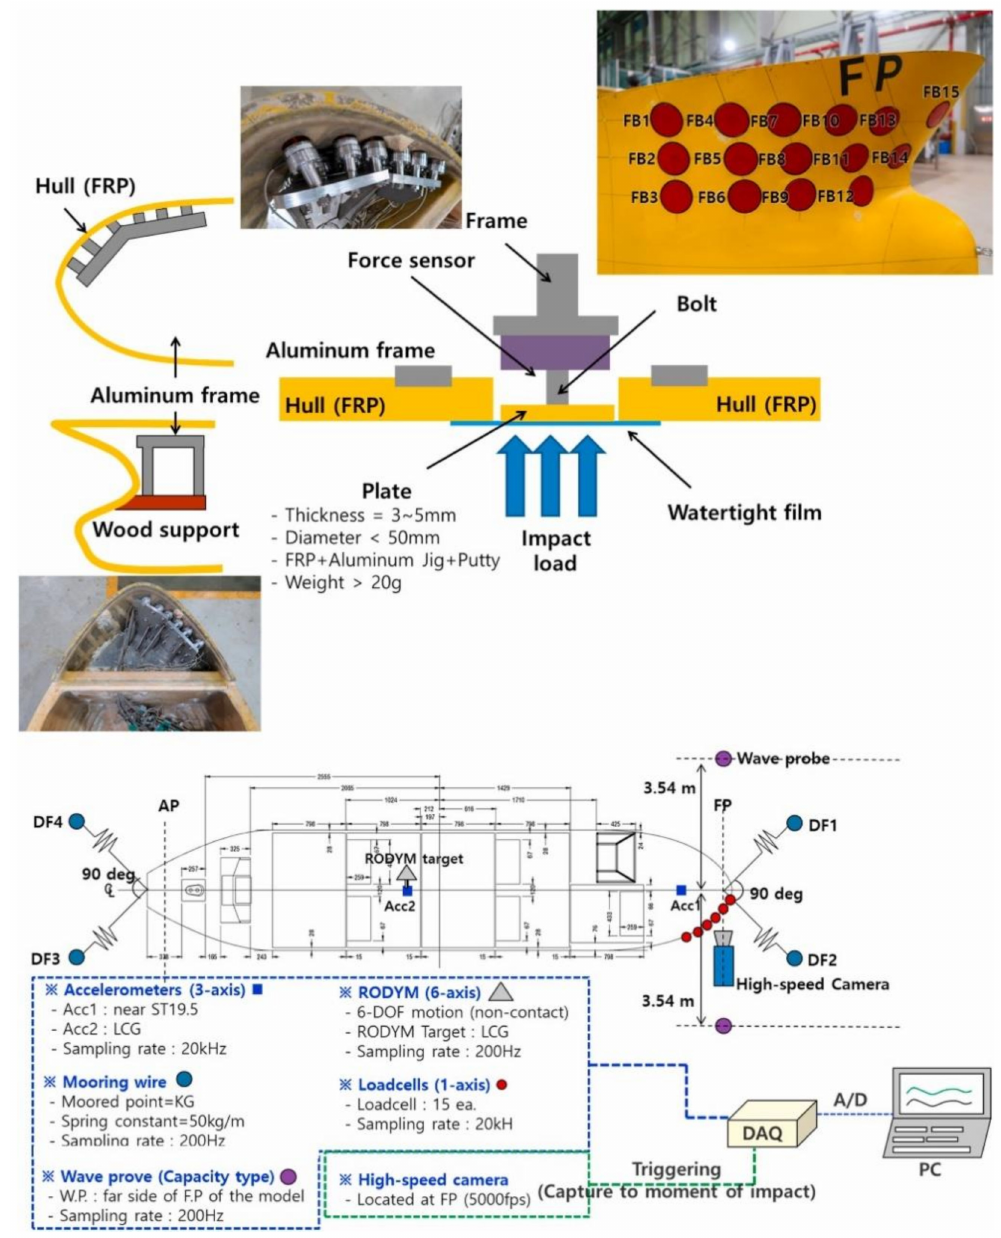
Figure 11. TENG tilt sensor experimental apparatus